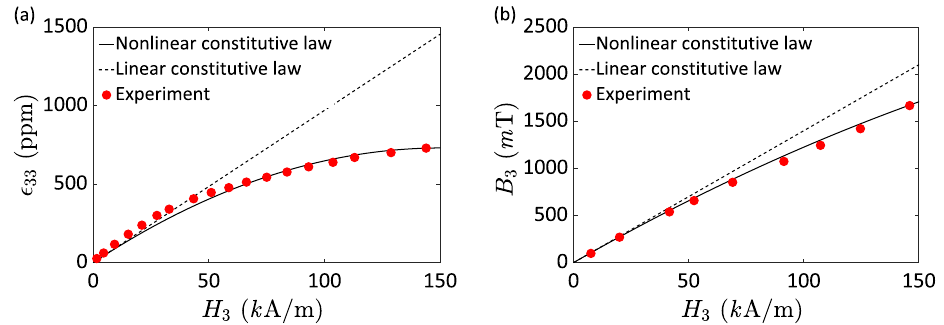
Figure 4. Strain ( a ) and magnetic flux density ( b ) responses of a stress-free magnetostrictive Terfenol-D rod due to an applied magnetic field (experimental data measured from a 20 kA/m bias field obtained from Jiles and Thoelke 17 .